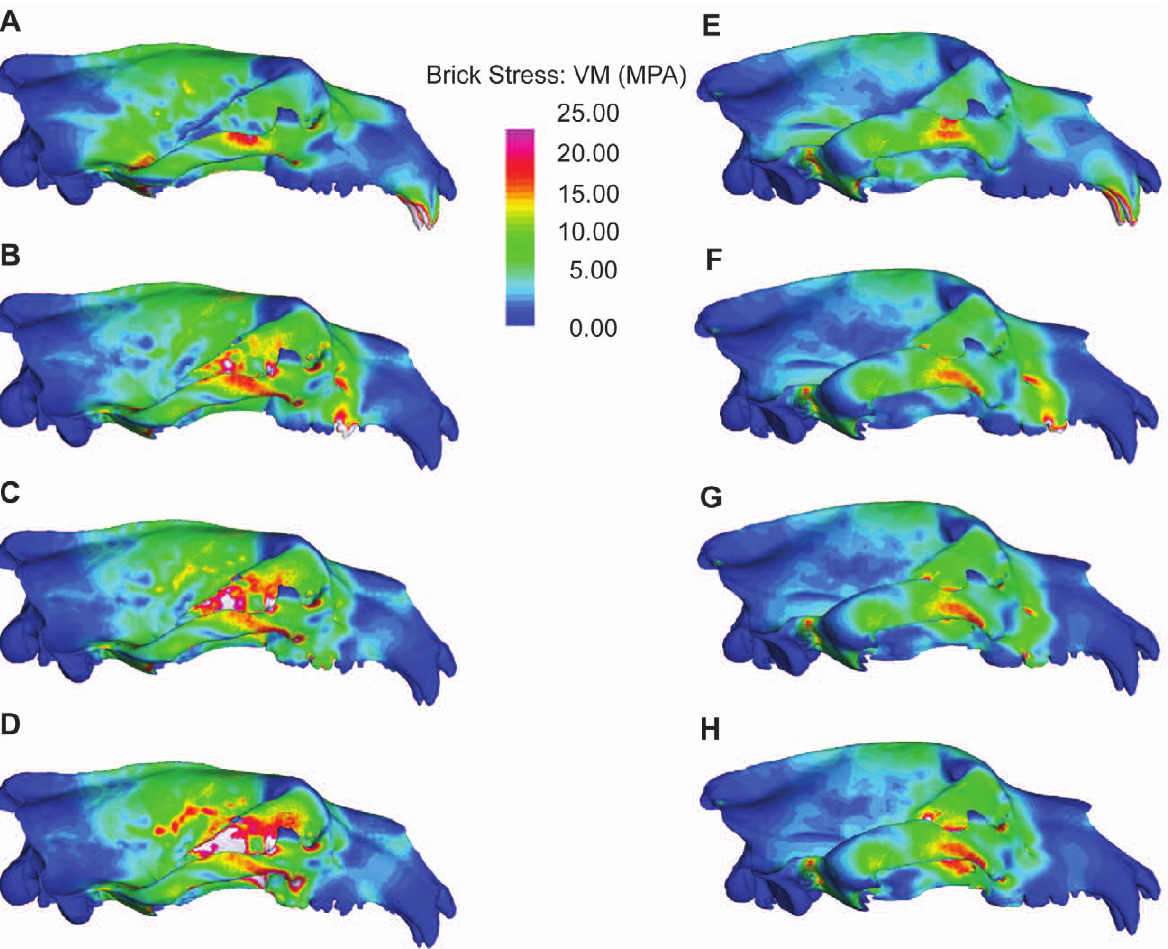
Figure 3. FE models showing von Mises stresses in the polar bear (left) and brown bear (right) skulls during bilateral canine biting (A,E), and unilateral PM4 (B,F), M1 (C,G), and M2 (D,H) biting.